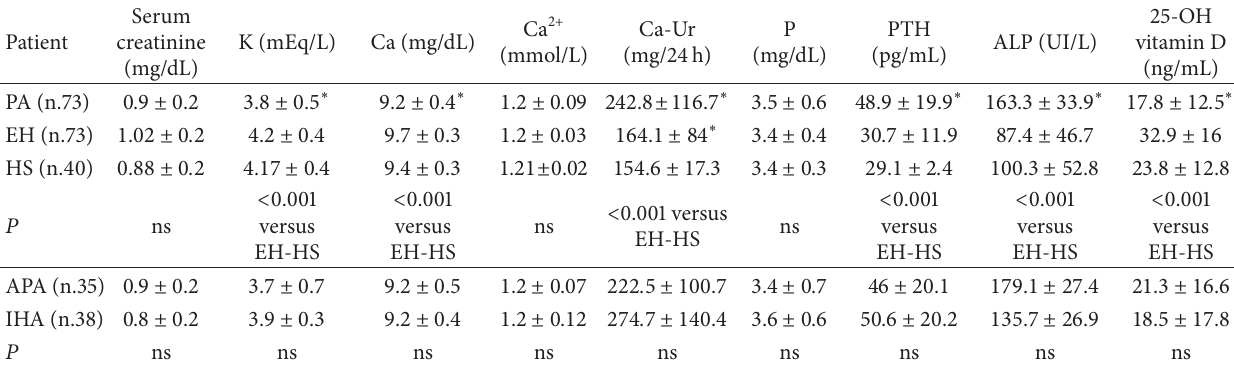
Table 2: Biochemical parameters of all subjects